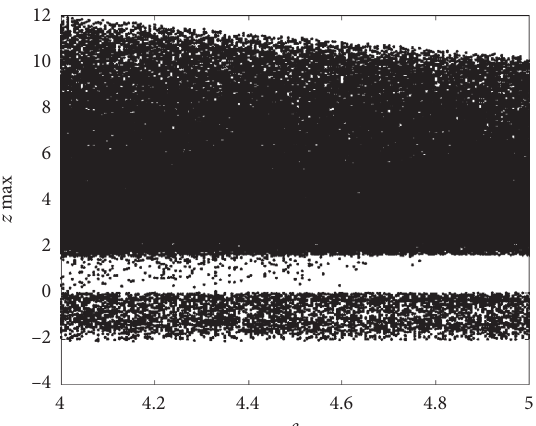
Figure 18: Bifurcation diagram according to the variation of parameter k